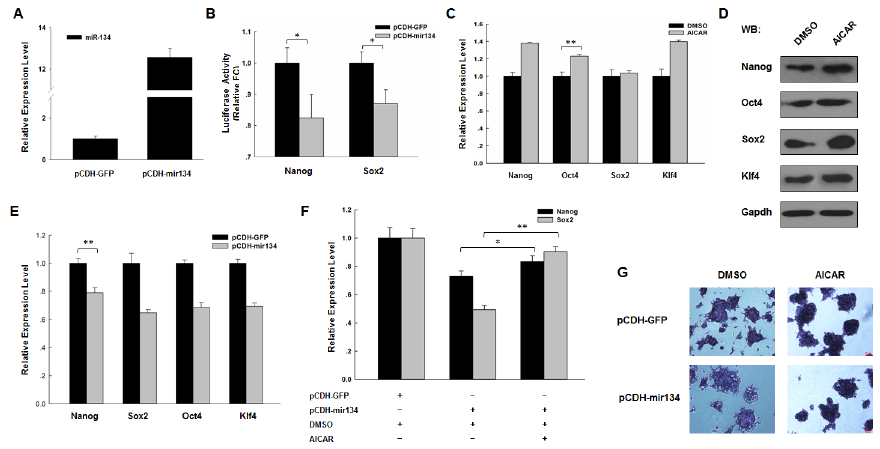
Figure 3. Down-regulation of miR-134 is partly responsible for increased expression of pluripotency markers. (A) MiR-134 expression vector pCDH-mir134 and its negative control were transfected into J1 ES cells, and the expression of miR-134 was detected by real-time PCR. (B) The luciferase reporters psi-Nanog or psi-Sox2 were co-transfected with miRNA expression vectors pCDH-mir134, and empty vector pCDH-GFP without insertion was used as control. 48 h after transfection, luciferase activity was detected using dual-luciferase reporter assay. (C) Real-time PCR validation of Nanog, Oct4, Sox2, and Klf4 in J1 ES cells in the presence or absence of 1 mM AICAR for 24 h using the comparative Ct method. Gapdh was used to normalize template levels. (D) Western blot analysis of pluripotency markers Nanog, Oct4, Sox2 and Klf4 in J1 ES cells in the presence of 1,000 U/ml LIF and with or without 1 mM AICAR for 24 h. Cell lysates were extracted and analyzed by western blot. Relative expression levels were comparing to Gapdh. (E) MiR-134 expression vector pCDH-mir134 and its negative control were transfected into J1 ES cells. 48 h after transfection, Nanog, Sox2, Oct4, and Klf4 expression was detected by real-time PCR. Gapdh was used to normalize template levels. (F) MiR-134 expression vector pCDH-mir134 and its negative control were transfected into J1 ES cells. 12 h after transfection, AICAR or DMSO was added to the cell culture medium, and Nanog and Sox2 expression was detected by real-time PCR. (G) MiR-134 expression vector pCDH-mir134 and its negative control were transfected into J1 ES cells. 12 h after transfection, AICAR or DMSO was added to the cell culture medium, and alkaline phosphatase staining of J1 cells were performed 24 hours later. (WB: western blot; *: p , 0.05; **: p , 0.01).